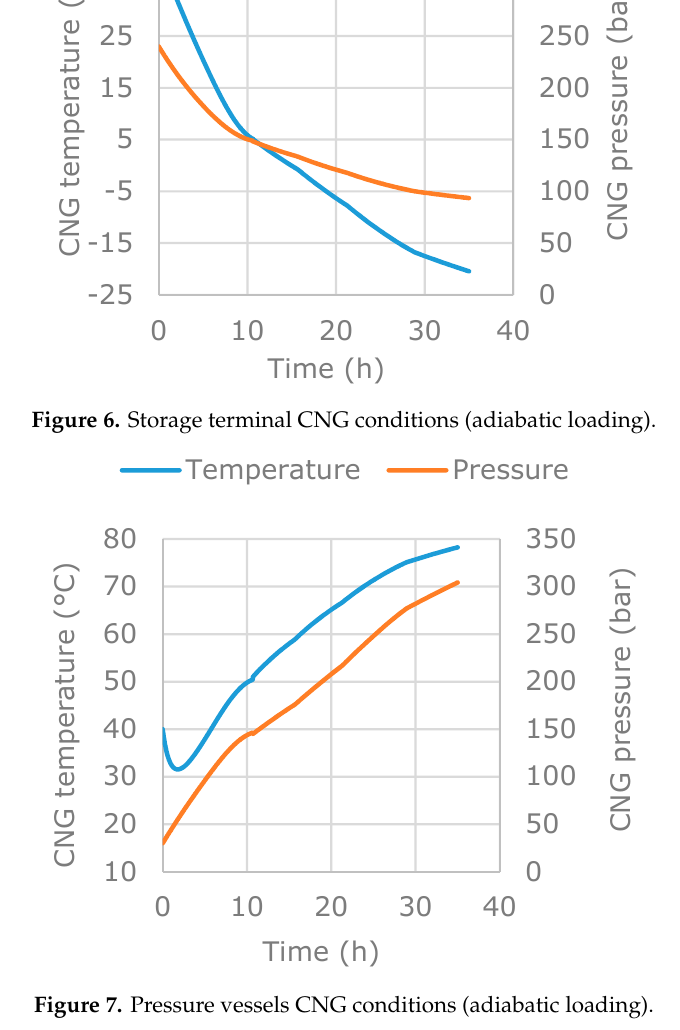
Figure 8. CNG flow rate (adiabatic loading).